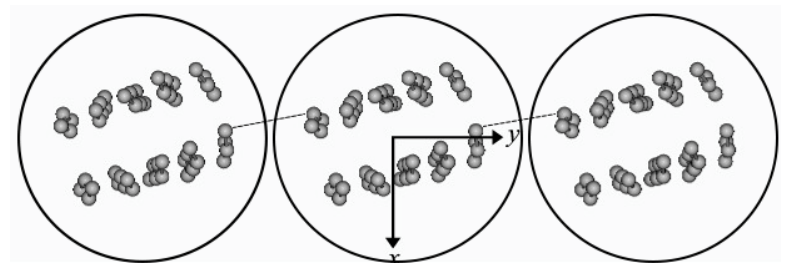
Figure 8. An axial projection of neighboring filaments in feather keratin showing their common orientation, as deduced from the row line pattern seen in the X-ray diffraction pattern. The ß-sandwiches are inclined at an angle of 17° to the plane of the sheet and this results in a ß-sheet in one filament lining up with a ß-sheet in a neighboring filament. Reproduced from [63] with permission of Elsevier.